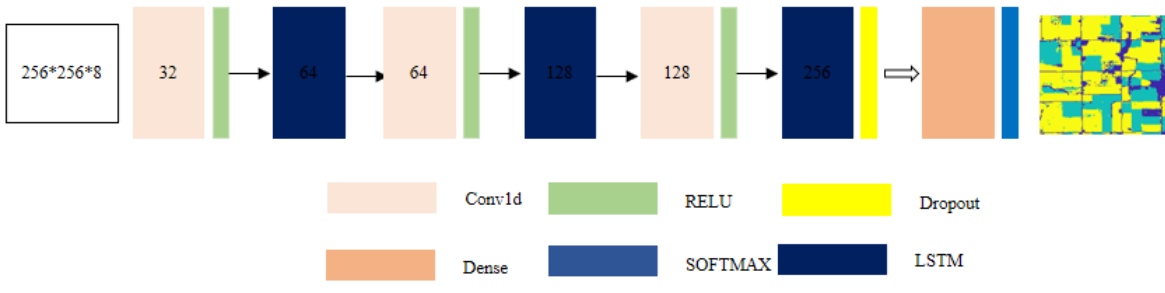
Figure 7. Proposed CNN-LSTM